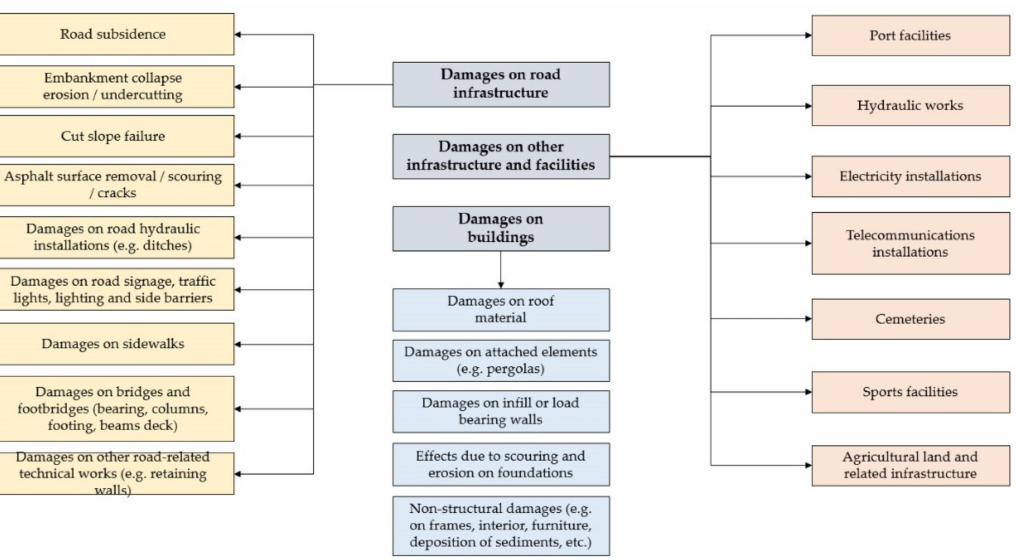
Figure 3. Types of effects on various elements of the man-made environment, regarding road-related infrastructure, buildings, and other facilities.